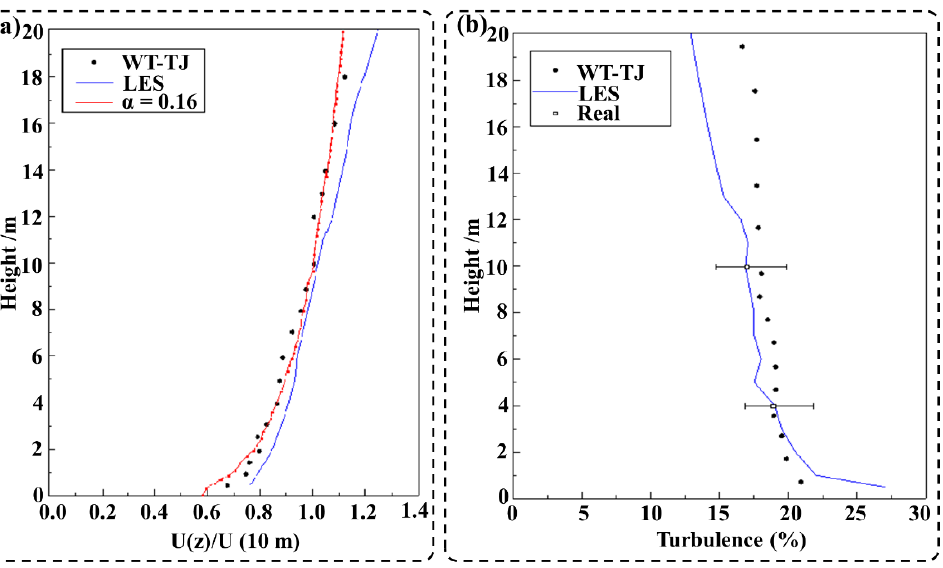
Figure 5. Comparison of wind fields: ( a ) mean wind speed profile; ( b ) flow turbulence profile.